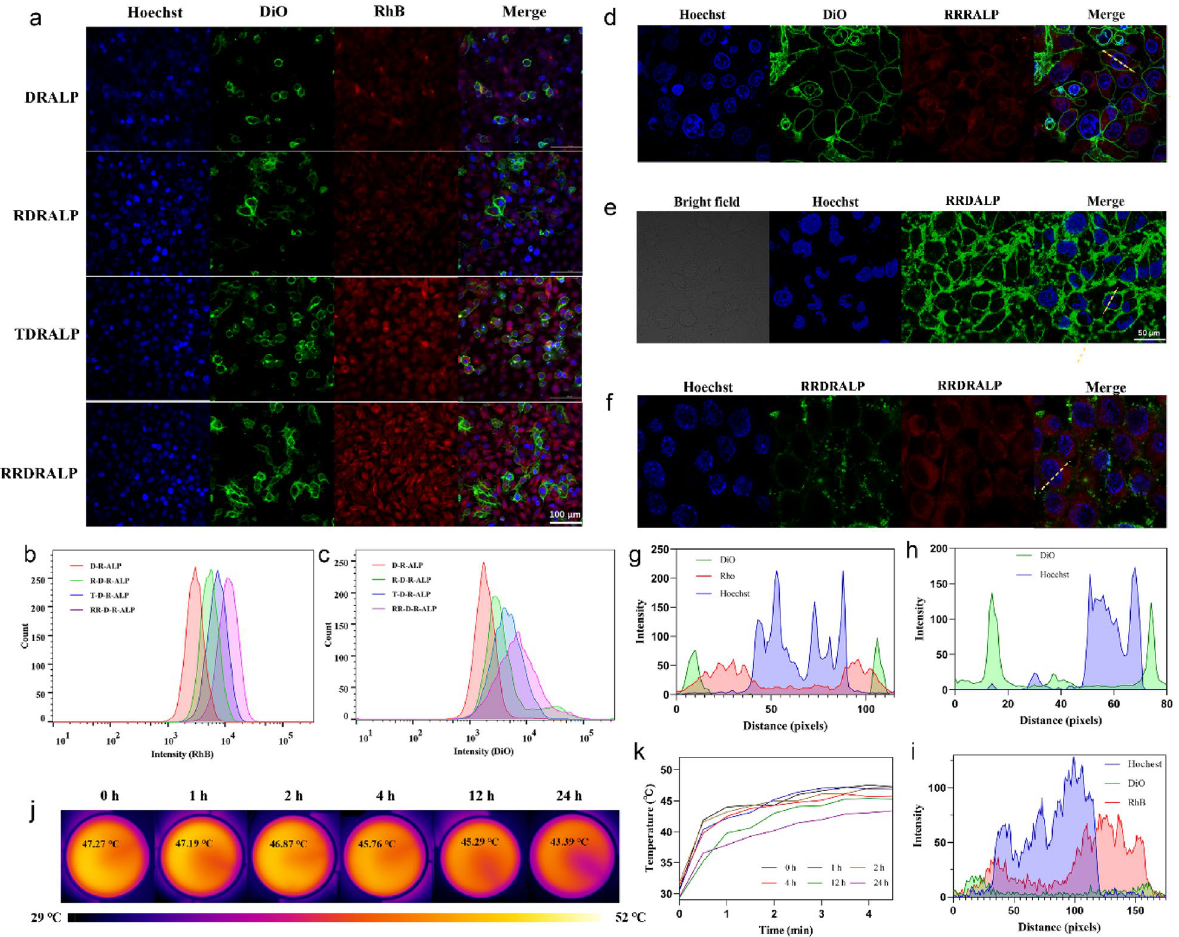
Fig. 5 Cell targeting and uptakes of liposomes. a CLSM images of A549 cells treated with DRALPs for 30 min (Blue channel: nucleus; Green and Red channels: liposomes). b , c Fluorescence analysis of RhB and DiO in A549 cells. d – f CLSM images (100 RRRALP, RRDALP, and RRDRALP respectively (the stain of the membrane in the RRRALP group was DiO alone). g – i Fluorescence profile analysis of the yellow dashes in CLSM images. j , k Thermal images of A549 cells treated with RRIALP-4 (2 mg/mL) in different times (irradiated with 808 nm laser at 0.3 W/cm 2 for 5